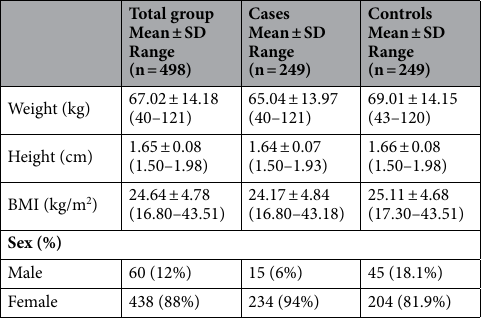
Table 1. Comparison of demographic characteristics of the total sample, patients with foot problems and controls. BMI body mass index, SD standard deviation.